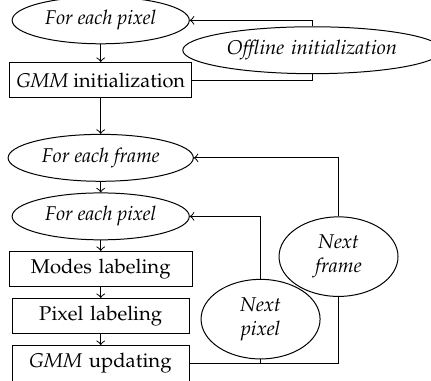
Figure 2. Algorithm of the classic Gaussian Mixing